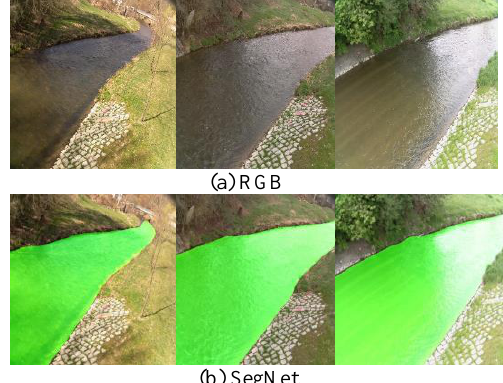
Figure 6. Examples of different point of views in (a) original images; (b) SegNet segmented